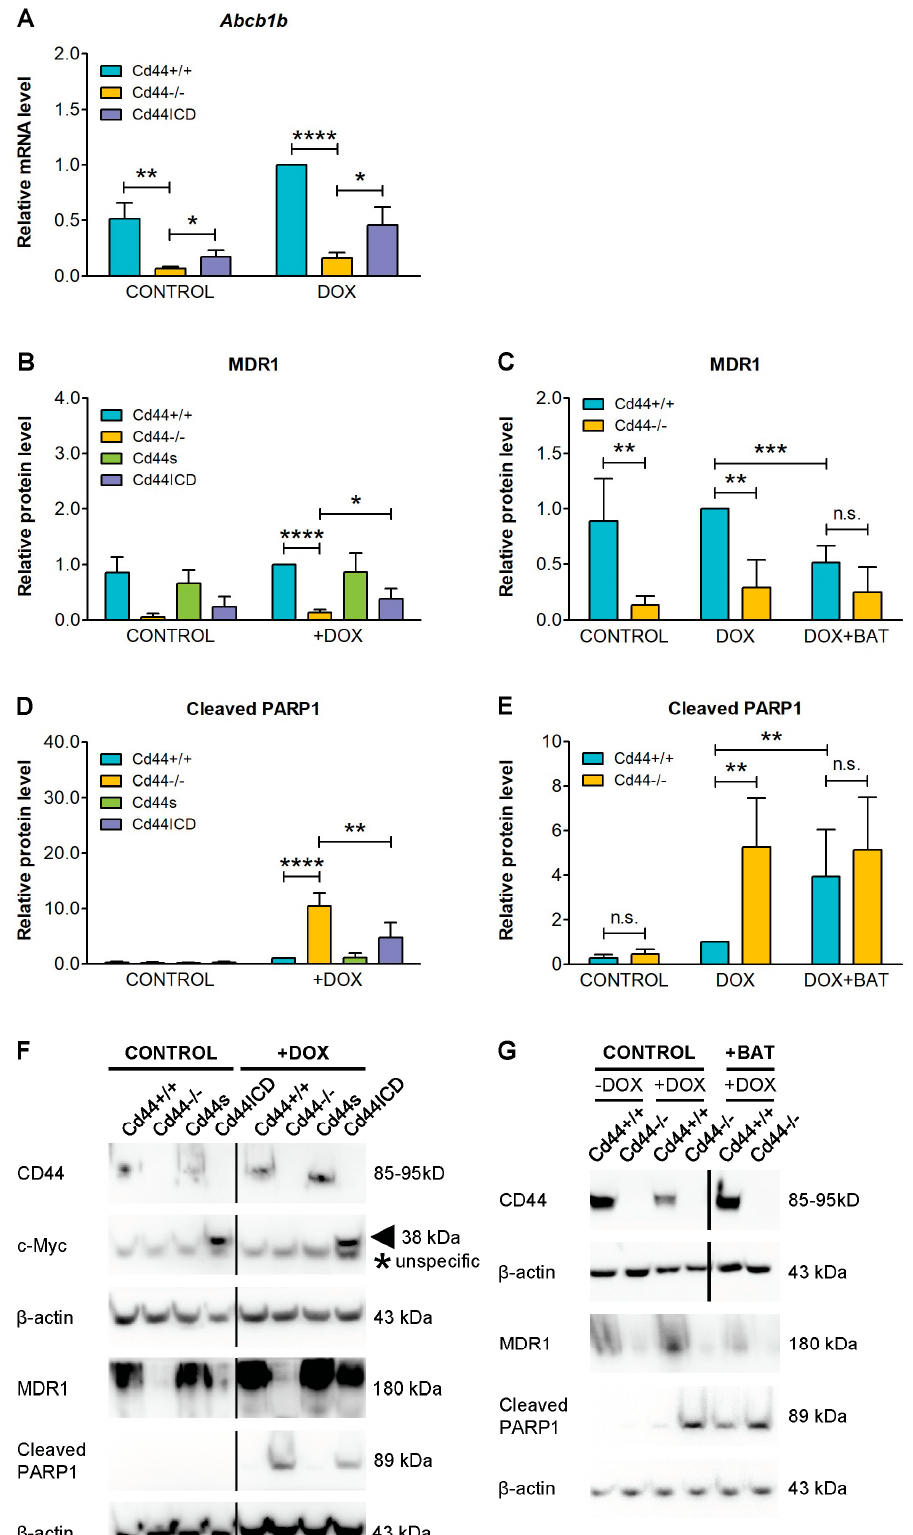
Figure 4. Involvement of CD44 proteolytic cleavage in the regulation of MDR1 expression and doxorubicin (DOX) chemoresistance. ( A ) CD44 potentiates Abcb1b gene transcription. ( B – G ) Soluble intracellular domain of CD44 (Cd44ICD), mimicking cleavage product, significantly increases resistance to DOX; whereas, treatment with matrix metalloproteinase inhibitor batimastat (BAT)